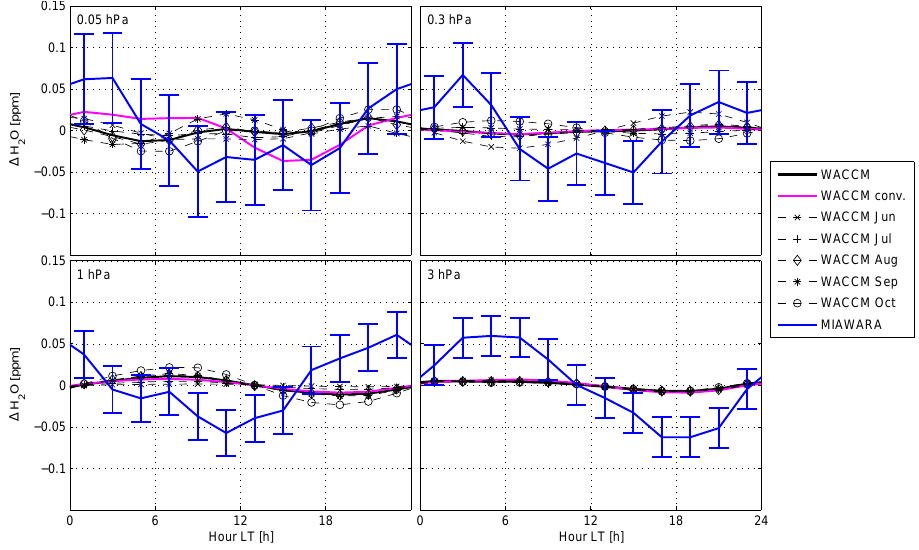
Fig. 4. Diurnal variations of water vapor as in Fig. 3 at four pressure levels (0.05, 0.3, 1 and 3hPa), including error bars for the observational data. The error bars are calculated by dividing the total uncertainty of an individual retrieval by the number of retrievals used for each bin. Systematic errors are not included. The solid black curve represents the 5-month average of the original WACCM data and the magenta curve represents the 5-month average of the convolved WACCM data. Also shown are the individual months (June to October) of the original WACCM